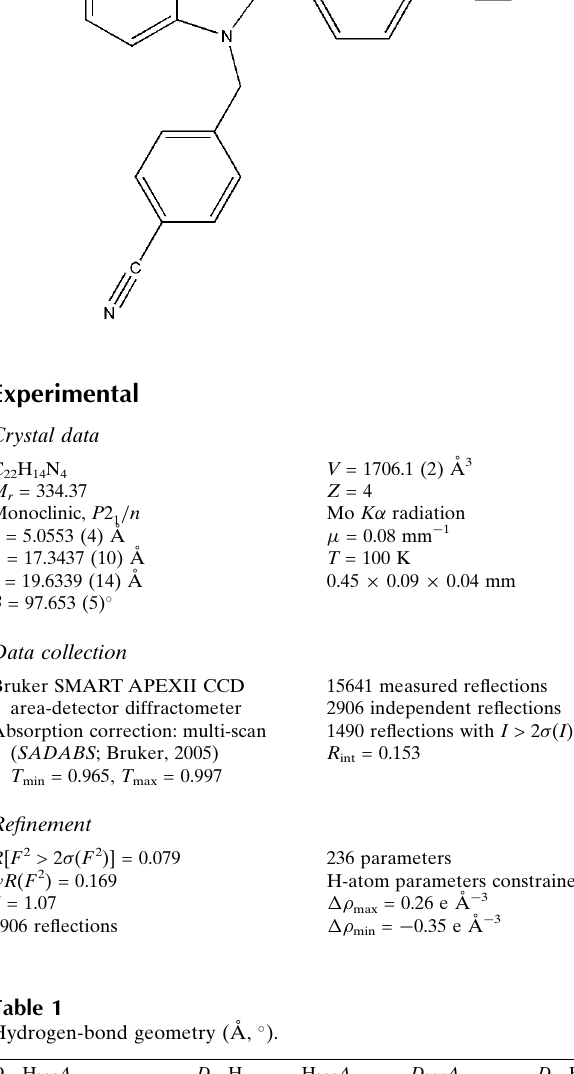
Hydrogen-bond geometry (A˚ , (cid:2)